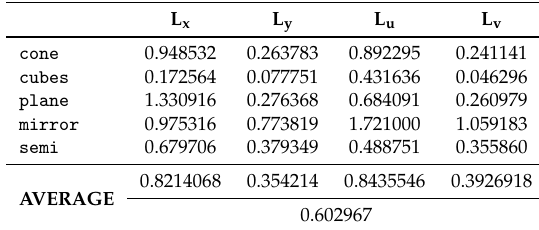
Table 8. Mean absolute differences of serial input design with respect to reference implementation using floating-point arithmetic. Pixel values range from 0 to 255.